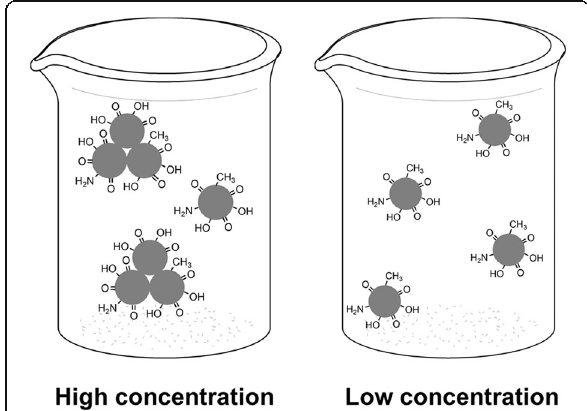
Fig. 5 The sketch of CDs at high concentration and low concentration. Left : when at high concentration, a number of single CD formed nanosized clusters; right : when at low concentration, the nanosized clusters separated into single